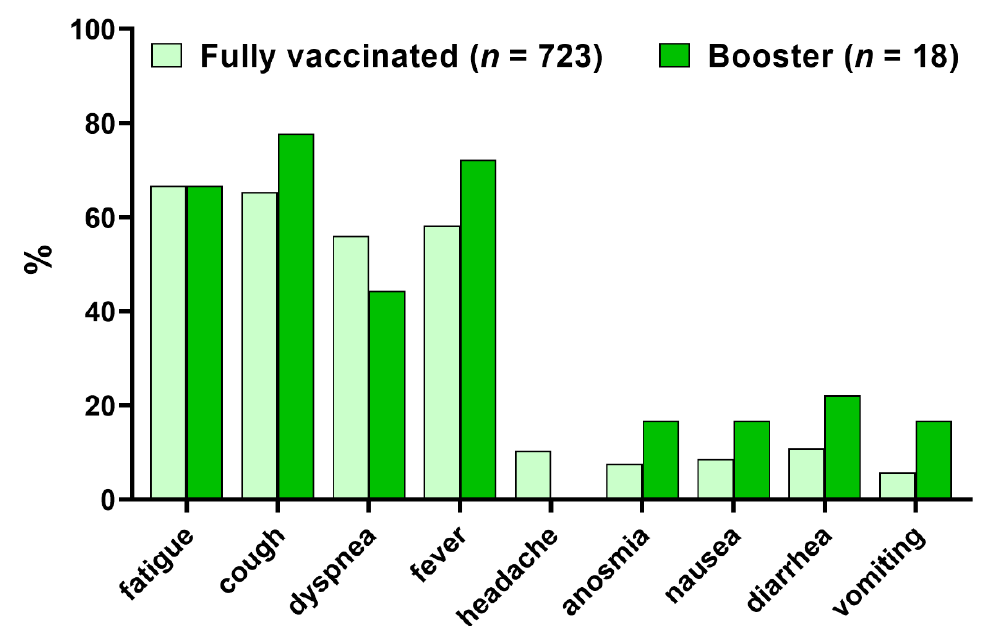
Figure 1. Frequency of early COVID-19 symptoms in vaccinated individuals requiring hospitalization ( n = 741). Table 2. Laboratory parameters (mean ± SD) at admission and clinical characteristics of vaccinated patients hospitalized with COVID-19.